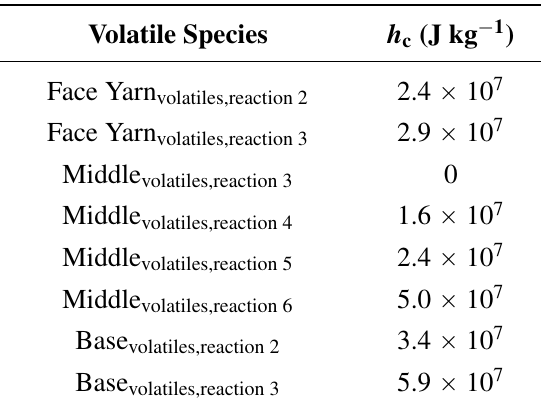
Table 3. Effective heat of combustion values for the volatile species released in each reaction. Positive heats of combustion are exothermic.